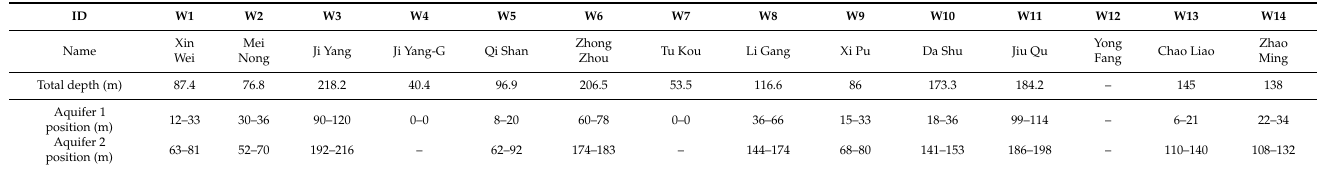
Table 1. Observation wells depth and aquifers position in study